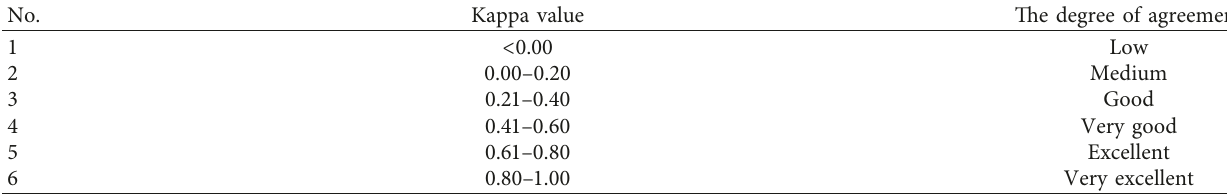
Table 5: Strength of agreement of a kappa coefficient [44].